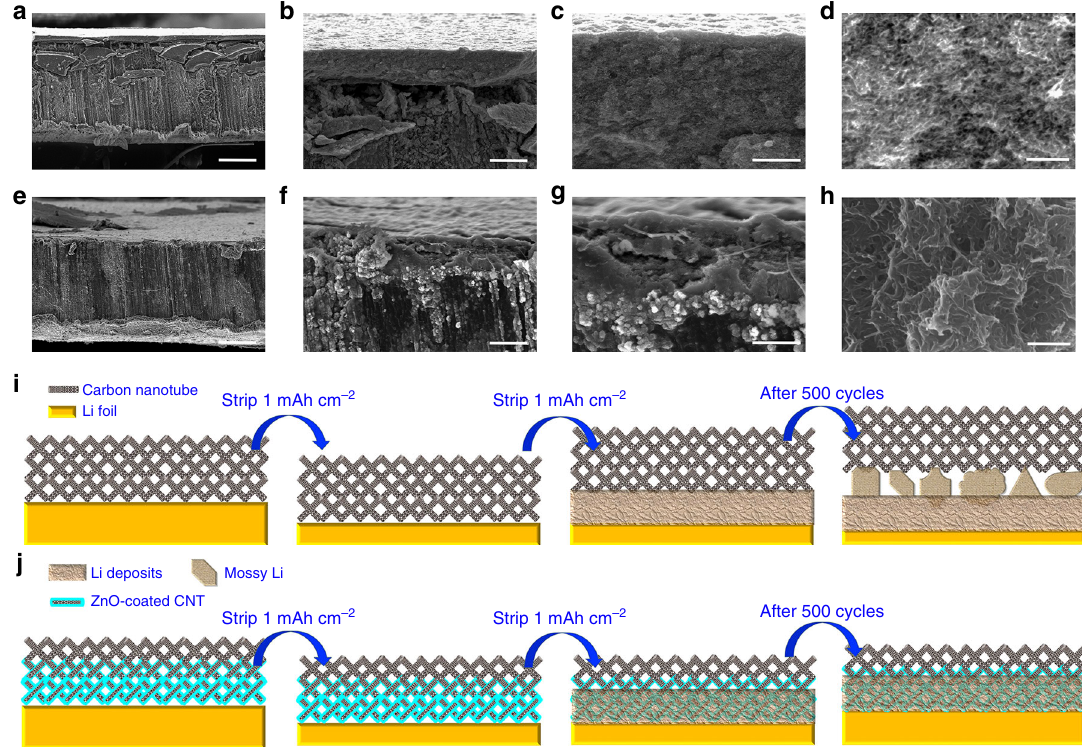
Fig. 7 Well-con fi ned stripping and plating behavior of the GZCNT-coated Li foil. a – h SEM images with various magni fi cations of cross-sectional view morphology of the Li cells coated with a CNT ( a – d ) or GZCNT ( e – h ) interfacial layer and cycled at a current density of 1 mA cm – 2 with a stripping/plating capacity of 1 mAh cm – 2 after 520 cycles . i , j Li stripping/plating mechanism of Li foils coated with a i CNT and j GZCNT interfacial layer where, after extended stripping/plating, a mossy Li layer forms between the CNT layer and Li foil ( i ), while the Li deposits nucleate at the surface of the underlying lithiophilic part of GZCNT, leading to a tightly anchored Li/CNT interface while the upper lithiophobic layer that avoids the deposition of Li, consequently avoiding dendrite growth from the electrode and any corrosion layer between the CNT and Li foil. Scale bar, 100 μ m for a , e , 20 μ m for b , f , 5 μ m for c , g , and 1 μ m for d ,